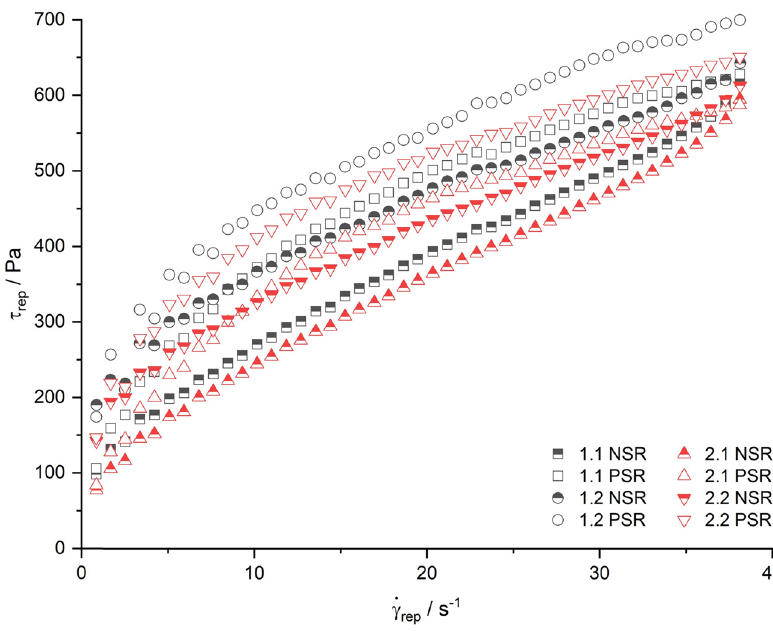
Figure 9: Representative values of the hysteresis measurements of SCC for performing two measurement series with two individual measurements